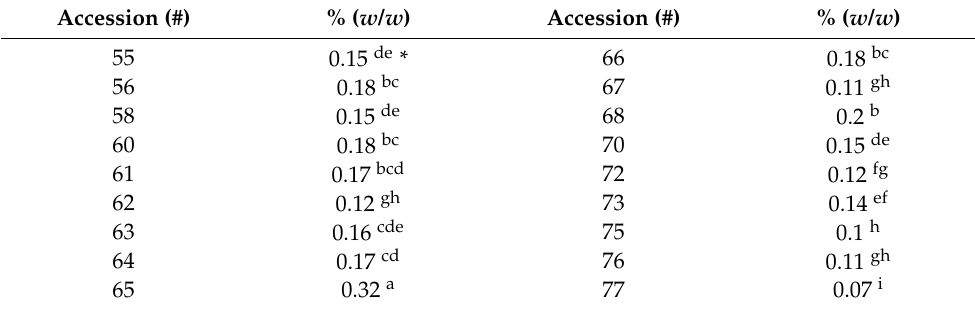
Table 5. Mean % of podophyllotoxin in the biomass ( w / w ) obtained from the 18 accessions of J. sabina . Means sharing the same letter are not significantly